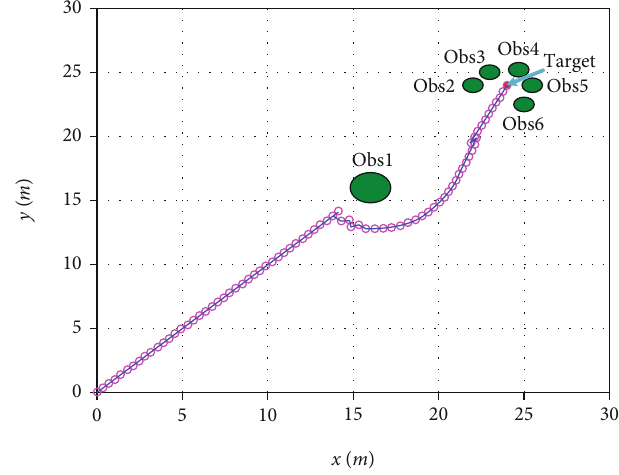
Figure 8: Scenario 1: the result of path planning of the proposed algorithm.